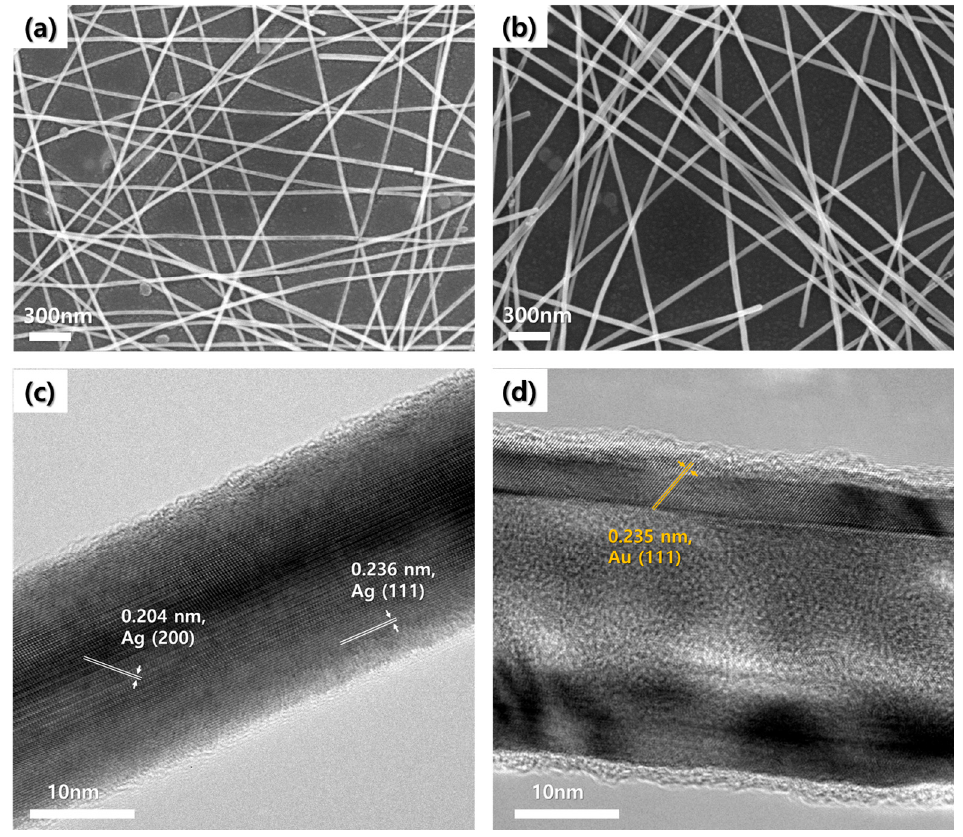
Figure 2. SEM and TEM images of Ag NWs and AACS NWs. ( a ) SEM image of the Ag NW network. ( b ) SEM image of the AACS NW network. ( c ) TEM image of a pristine Ag NW. ( d ) TEM image of an AACS NW.